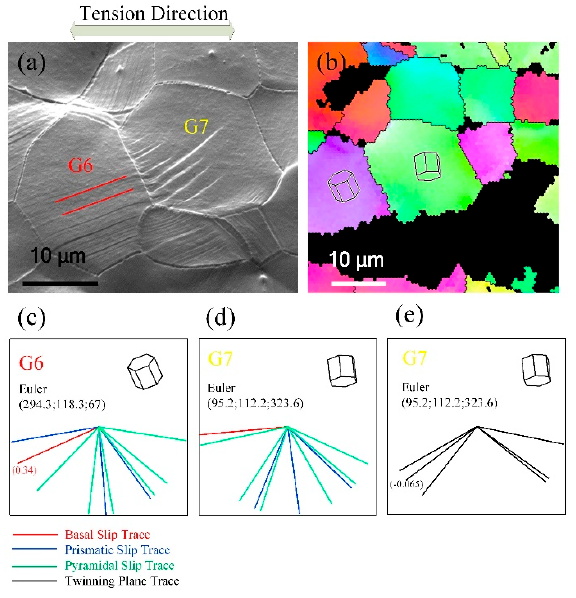
Figure 6. ( a ) SEM micrograph of Mg–8.0Gd–3.0Y–0.5 Zr alloy after tension test at strain of 0.1; ( b ) the corresponding IPF map; ( c ) possible slip trace directions in Grain 6; ( d ) possible slip trace directions in Grain 7; ( e ) possible twinning boundary trace directions in Grain 7.